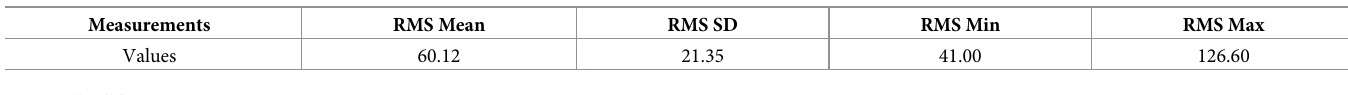
Table 1. The root-mean-square values of the IOS-scanned and CBCT-scanned digital models ( μ m). Measurements